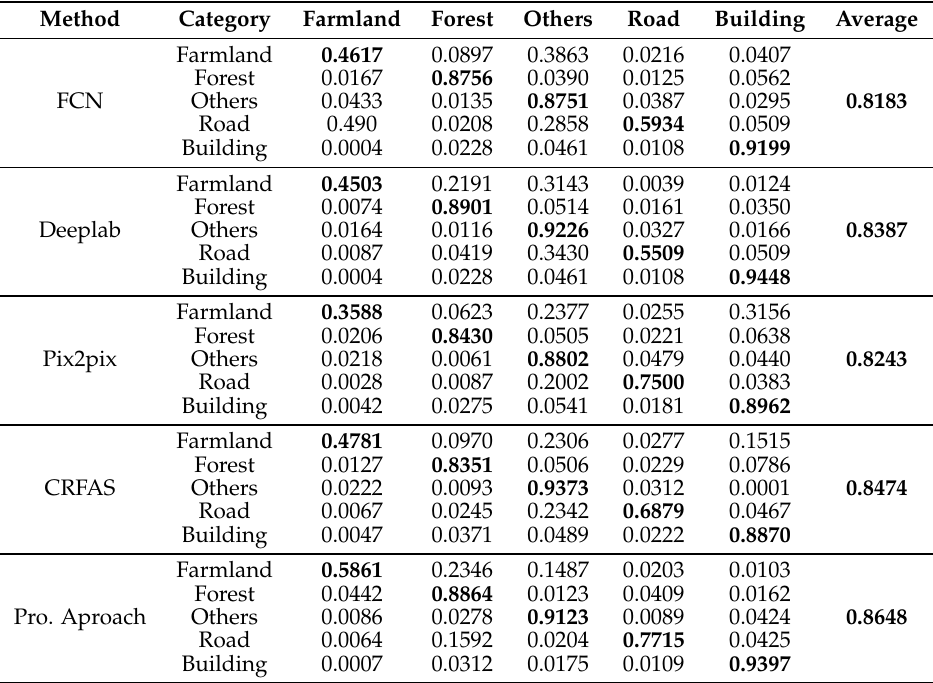
Table 1. Confusion matrix for ESAR